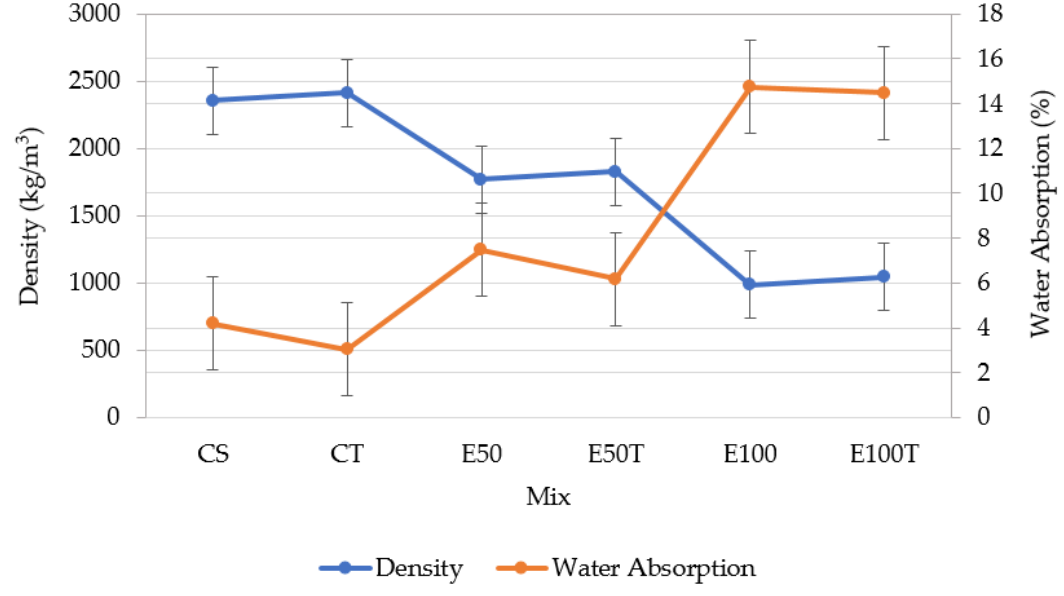
Figure 7. Density and water absorption of mix specimens.